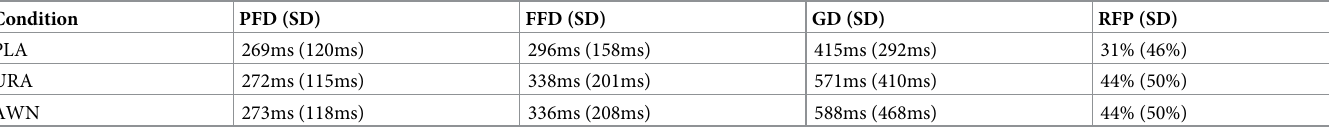
Table 3. Eye-movement results.